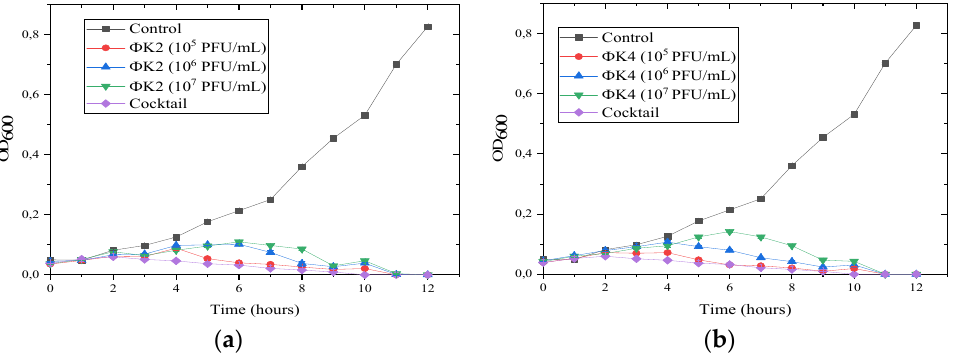
Figure 5. Susceptibility test of Φ K2 and Φ K4 against A. tumefaciens : ( a ) Φ K2; ( b ) Φ K4. The treatment cocktail is included in each graphic. Results are presented as mean values ± SD from three independent experiments.